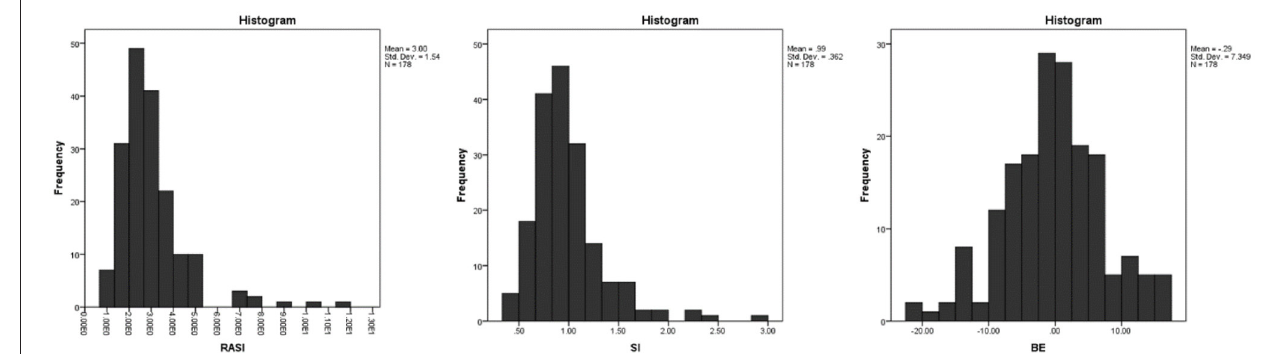
FIGURE 1 | Frequency of different values of BE, RASI and SI.